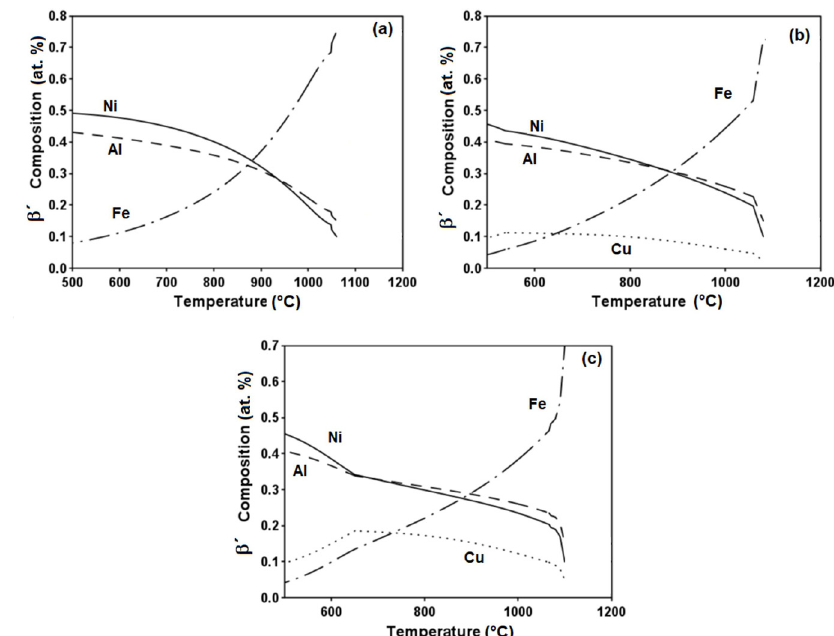
Figure 4. Plot of Calphad calculated chemical composition of the β´ phase versus temperature for (a) Fe-10at.%Ni-15at.%Al, (b) Fe- 10at.%Ni-15at.%Al-2.5at.%Cu and (c) Fe-10at.%Ni-15at.%Al-5at.%Cu alloys.